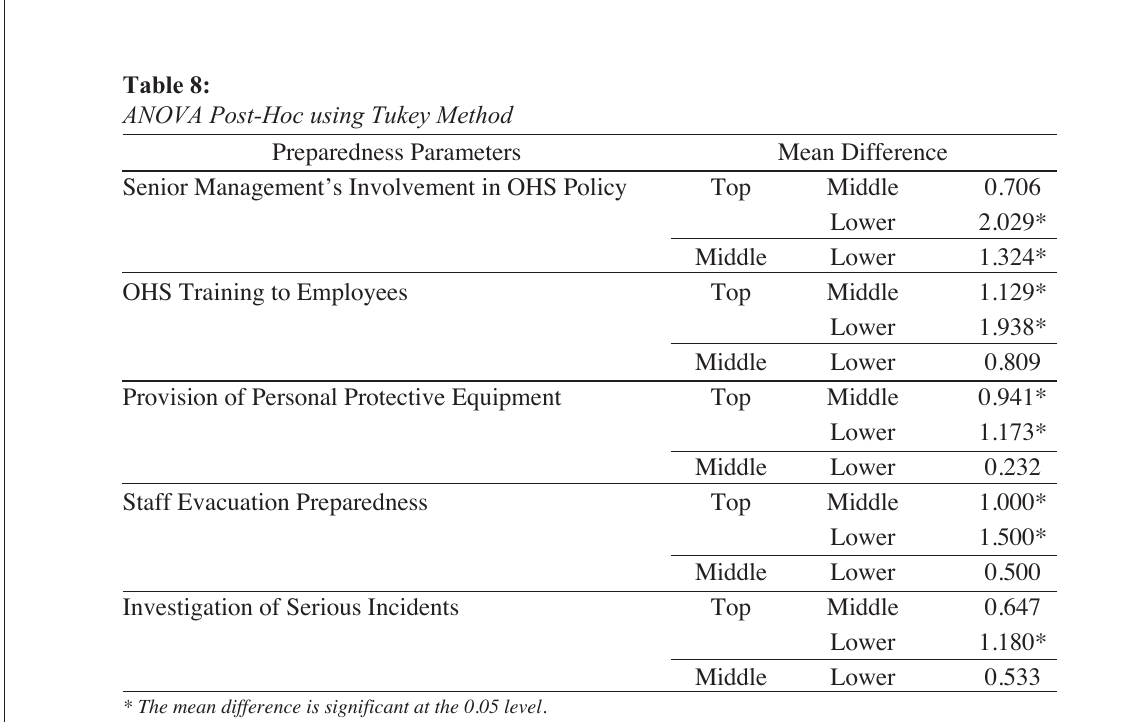
ANOVA Post-Hoc using Tukey Method